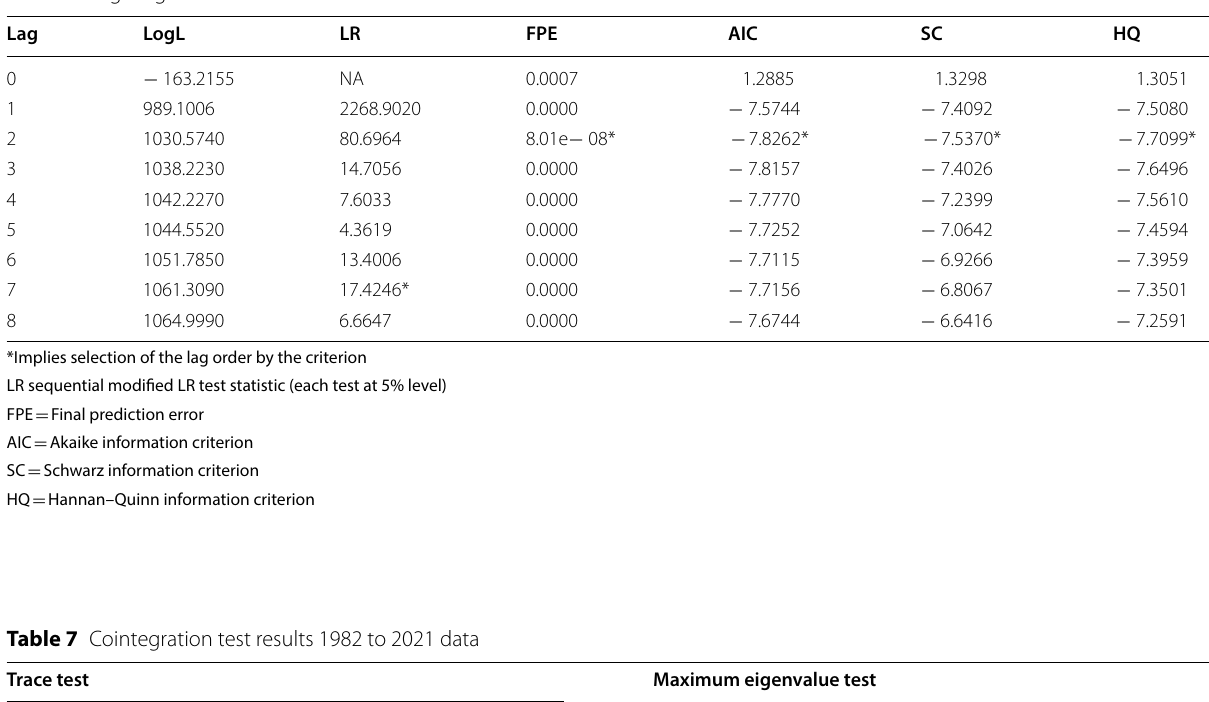
Table 6 Lag length selection 2000 to 2021 data